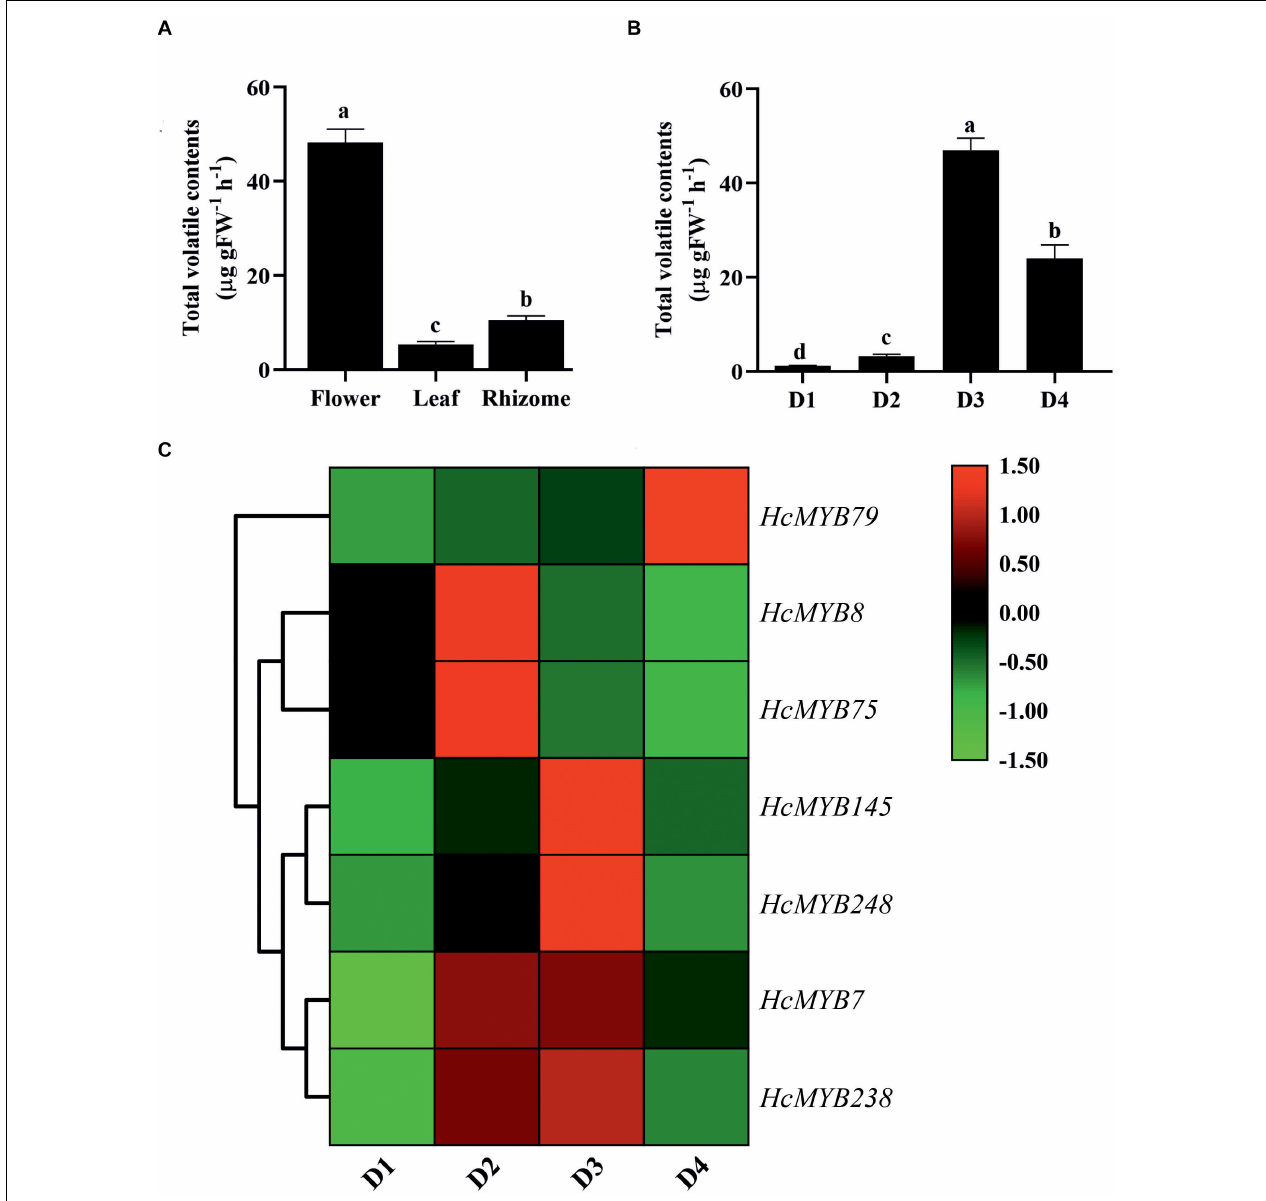
FIGURE 3 | The total volatile contents and expression levels of candidates HcMYB genes. (A) The total volatile contents emitted from flower, leaf, and rhizome. (B) The total floral volatiles released during different flower developmental stages (D1: squaring stage; D2: half open stage; D3: full-bloom; D4: senescence stage). (C) Differential expression patterns of selected candidate HcMYB genes during four different flower developmental stages. The heat map was generated with the relative expression RT-qPCR data of candidate HcMYB genes. The red (upregulated expression levels) and green (downregulated expression levels) color represent the log 2 transformed expression